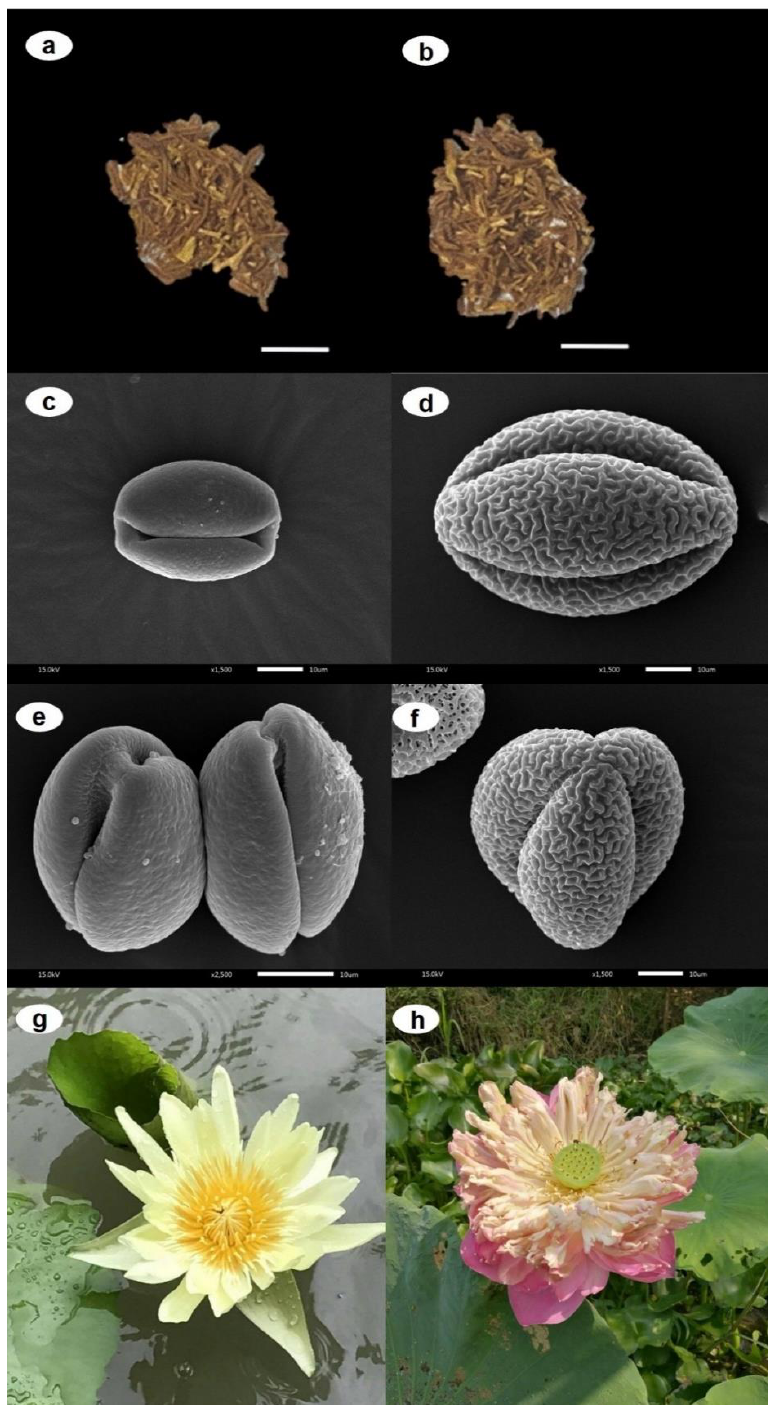
Figure 1. The dried stamens of ( a ) Nymphaea lotus (bar scale = 0.5 cm) and ( b ) Nelumbo nucifera (bar scale = 0.5 cm). The scanning electron microscopy (SEM) analysis of pollen from ( c , e ) N. lotus (bar scale = 10 µm) and ( d , f ) N. nucifera (bar scale = 10 µm). The living specimens of ( g ) N. lotus and ( h ) N. nucifera from the natural habitats. Photo by Duangjai Tungmunnithum.